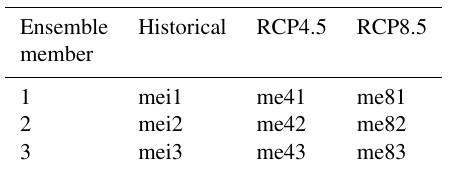
Table 1. Table explaining the logic behind the experiment names used in this paper. The last number in the name refers to the ensem- ble member. The third letter identifies whether the data refer to the historical period (i) or were generated under RCP4.5 (4) or RCP8.5 (8). Under RCP4.5 greenhouse gas emissions are expected to peak around the year 2040 and decline after that. Under RCP8.5 green- house gas emissions are expected to increase throughout the 21st